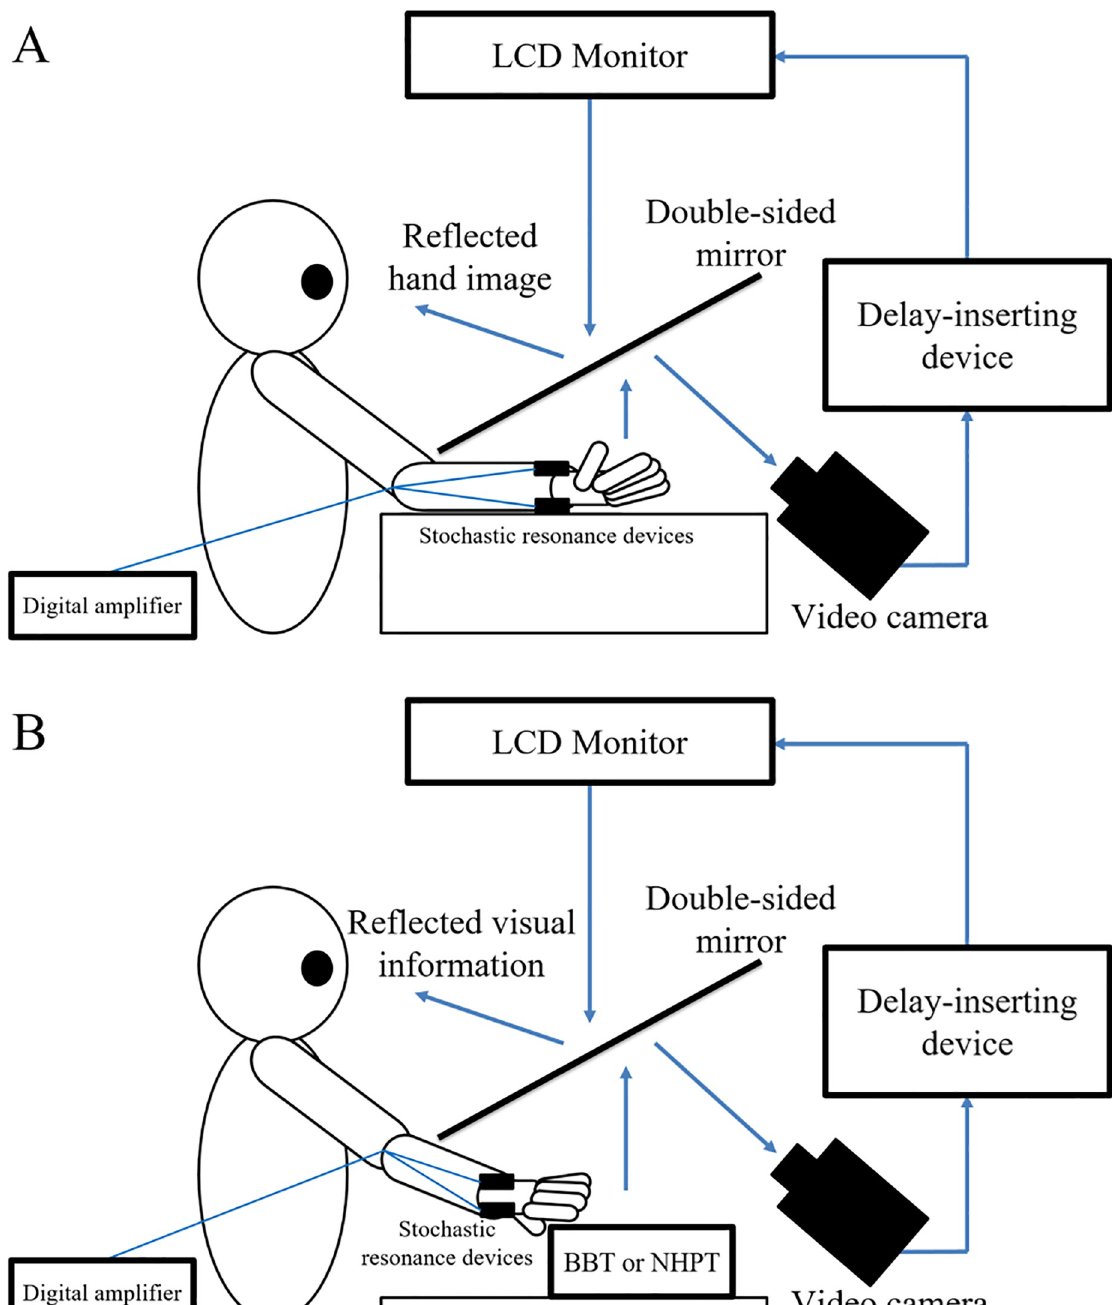
Fig 2. Video delay system and experimental tasks. The video delay system can insert a delay in the visual information from the video camera by the delay-inserting device and then project it to the monitor. Therefore, the participants observed delayed visual feedback with respect to the movement of their hand. (A) Delayed visual feedback detection task. The participants performed the task with an SR device attached to the right wrist. Fifteen delay conditions were set, and the participants were asked to answer whether the visual feedback of their self-generated hand movements was delayed or not delayed. The participants carried out this task in the SR on- and off-conditions. (B) Both hand motor function tests under delayed visual feedback were used. BBT, box and block test; NHPT, nine hole peg test. The participants carried out the BBT and NHPT under a delayed visual feedback of 267 ms with an SR device attached to the right wrist. The participants conducted these tasks in the SR on- and off-conditions.